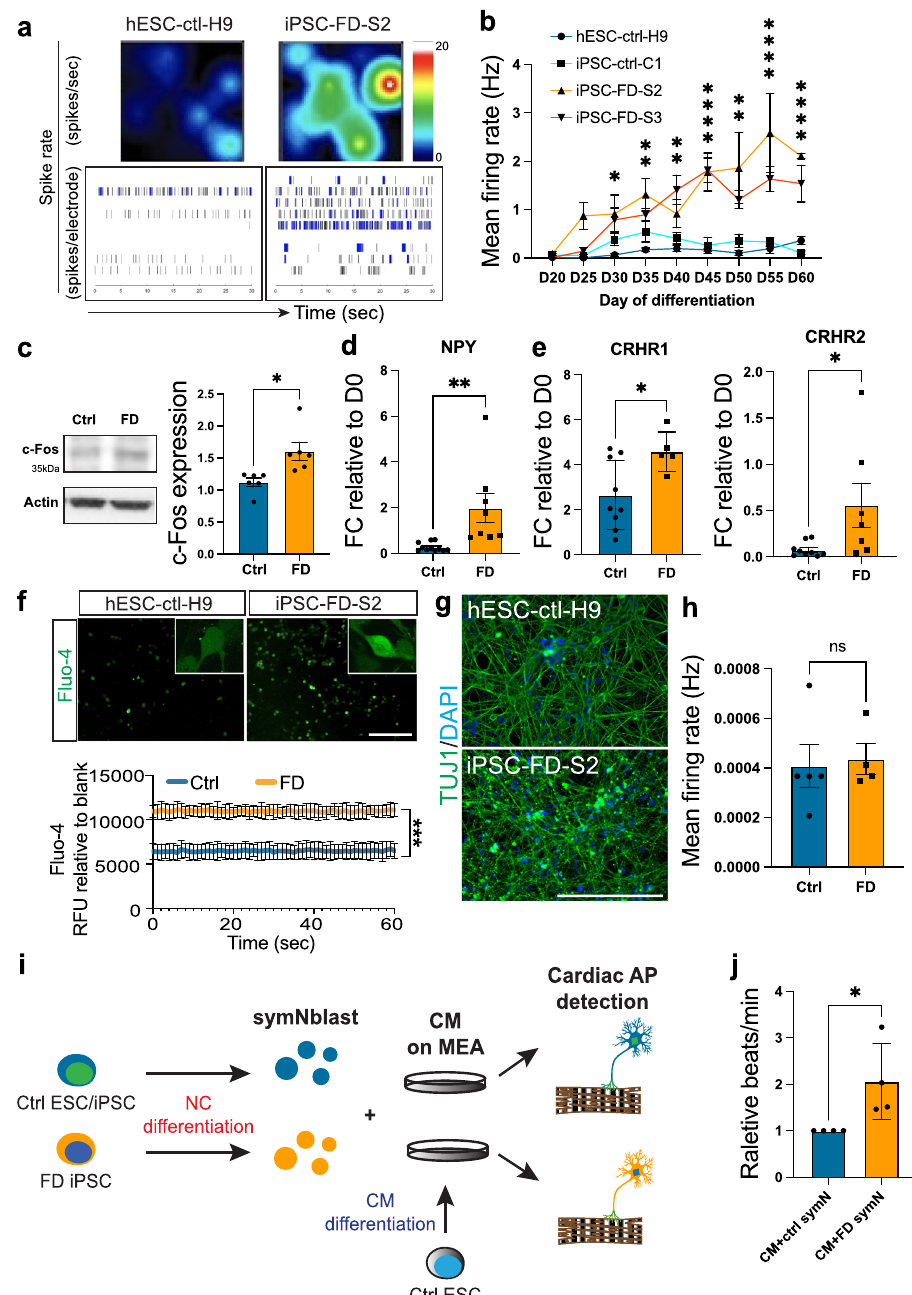
Fig.2|FamilialDysautnomiasympatheticneurons(symNs)arespontaneously hyperactive.a Multielectrodearray(MEA)heatmapsofneuralspikerate(toprow) and burst maps (bottom row, black bars represent spikes and blue bars represent bursts)onday35,showrepresentativepatternsofFDsymNhyperactivity. b SymN fi ringfrequenciesarecomparedusingMEAinatimecourse. N =(D20-H9:9,C1:10, S2:8,S3:6;D25-H9:9,C1:10,S2:6,S3:8;D30-H9:14,C1:16,S2:9,S3:9;D35-H9:10, C1:10,S2:18,S3:12;D40-H9:7,C1:13,S2:3,S3:10;D45-H9:3,C1:4,S2:3,S3:7;D50- H9: 3,C1: 8, S2: 4,S3: 11; D55-H9: 5,C1: 6, S2: 5,S3: 4;D60-H9: 6, C1:7, S2: 3,S3: 13) biological replicates. Two-way ANOVA followed by Š ídák multiple comparisons. ControlandFDwerecompared.ErrorbarrepresentstheSEM.* P <0.05,** p <0.01, **** P <0.0001. c Comparison and quanti fi cation of c-Fos expression by western blot between control and FD. N =6 biological replicates. Two-tailed Student ’ s t-test. Error bar represents the SEM. * p <0.05. RT-qPCR analysis of NPY ( d ) and CRHR1/2 ( e ) levels between control and FD. For NPY , N =(ctrl: 11, FD: 8) biological replicates. For CRHR1 , N =(ctrl: 9, FD: 5) biological replicates. For CRHR2 , N =(ctrl: 9, FD: 7) biological replicates. Two-tailed Student ’ s t-test. Error bar represents the